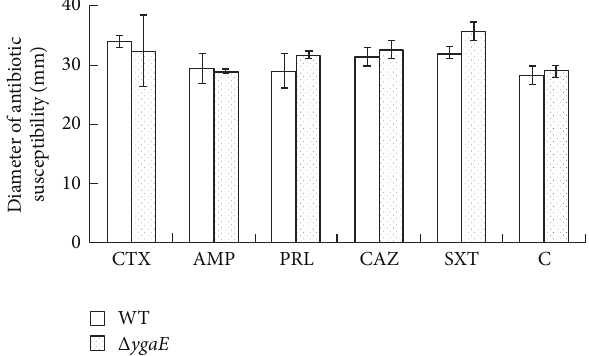
WT Figure 4: Antibiotic susceptibility of wild type and Δ ygaE under hyperosmotic stress measured by modified Kirby-Bauer disk dif- fusion method on Muller Hinton agar with a final NaCl con- centration of 300 mM. The antibiotic disks which were used in this study were cefotaxime (CTX), ampicillin (AMP), piperacillin (PRL), ceftazidime (CAZ), compound sulfamethoxazole (SXT), and chloramphenicol (C). The zone size around each antimicrobial disk was measured. The experiment was performed three times. Student’s 𝑡 -test was used for the statistical analysis. Differences were considered statistically significant when 𝑃 was <